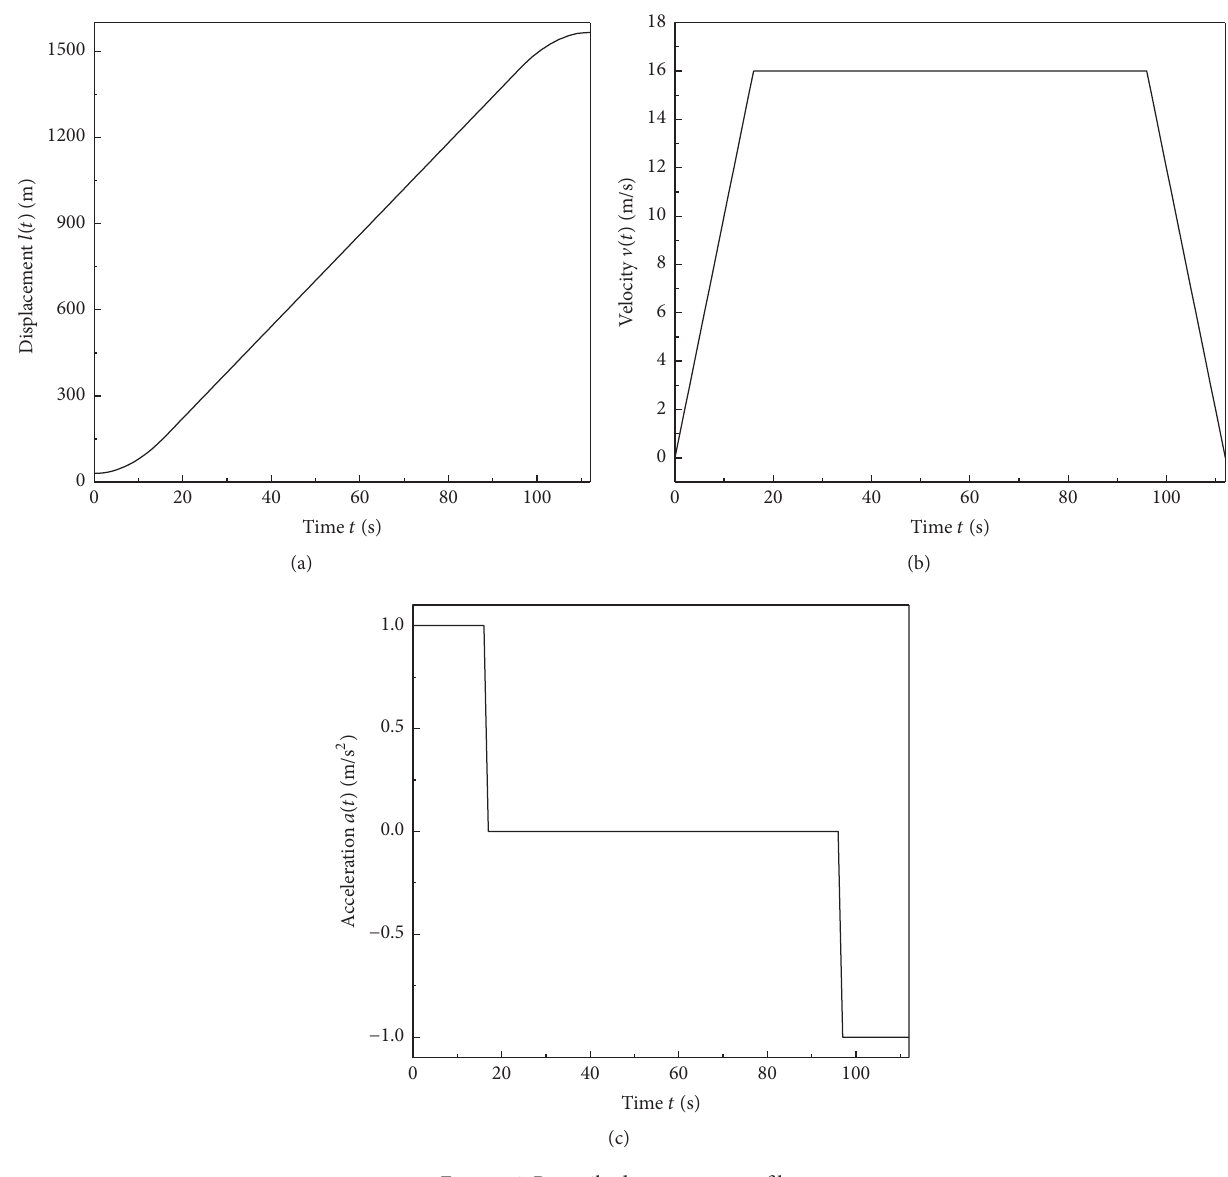
Figure 4: Prescribed movement